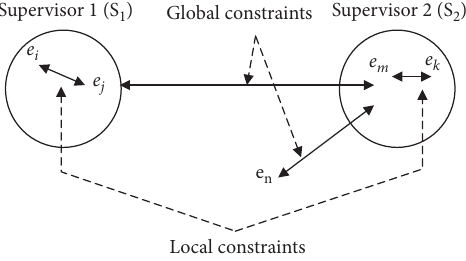
Figure 4: Global and local